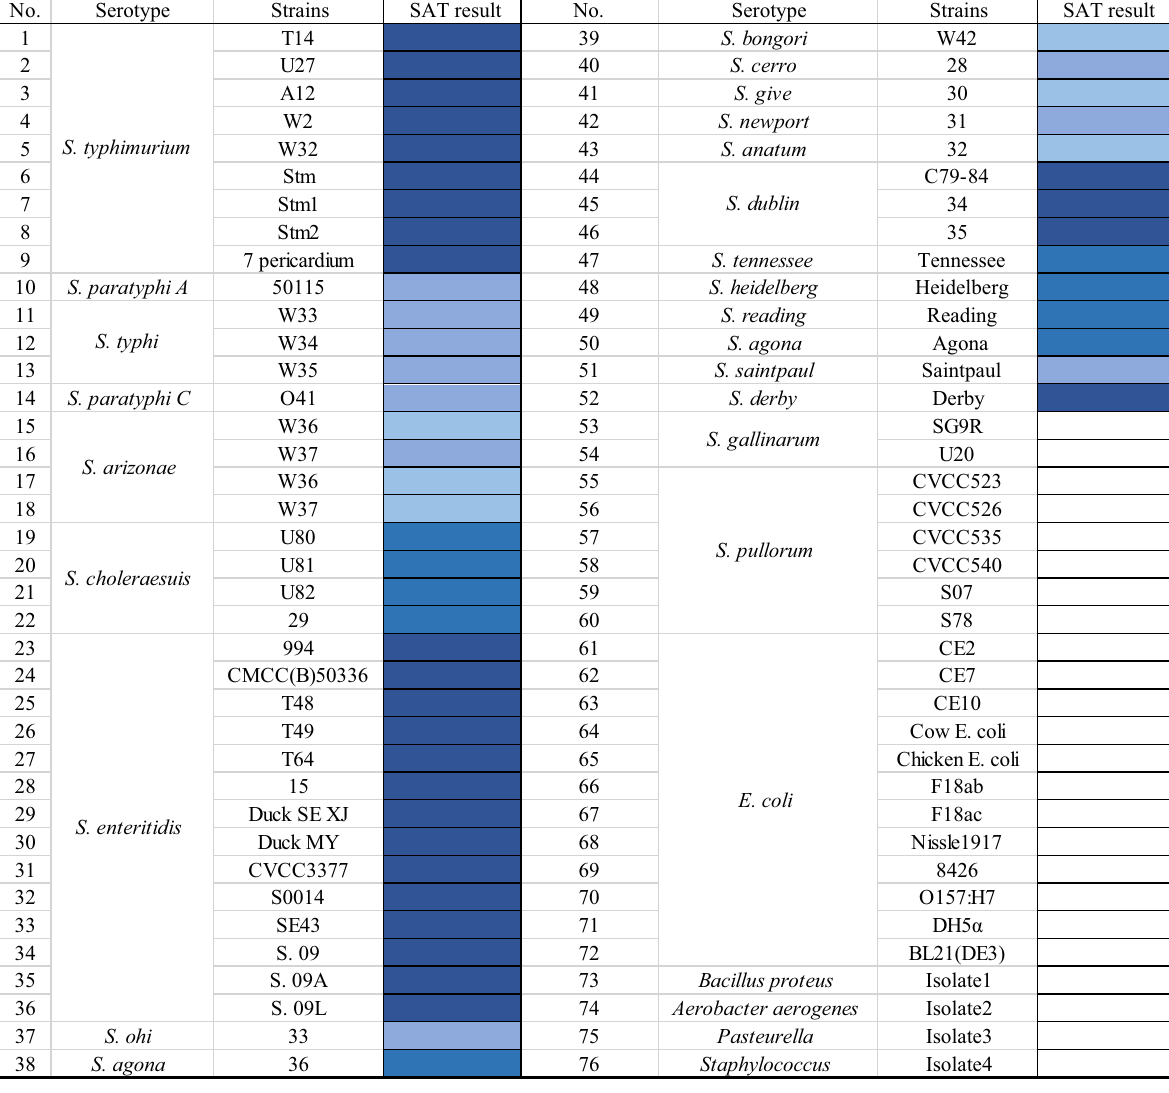
Table 1 Reactivity and specificity of MAb 3E2 in SAT method